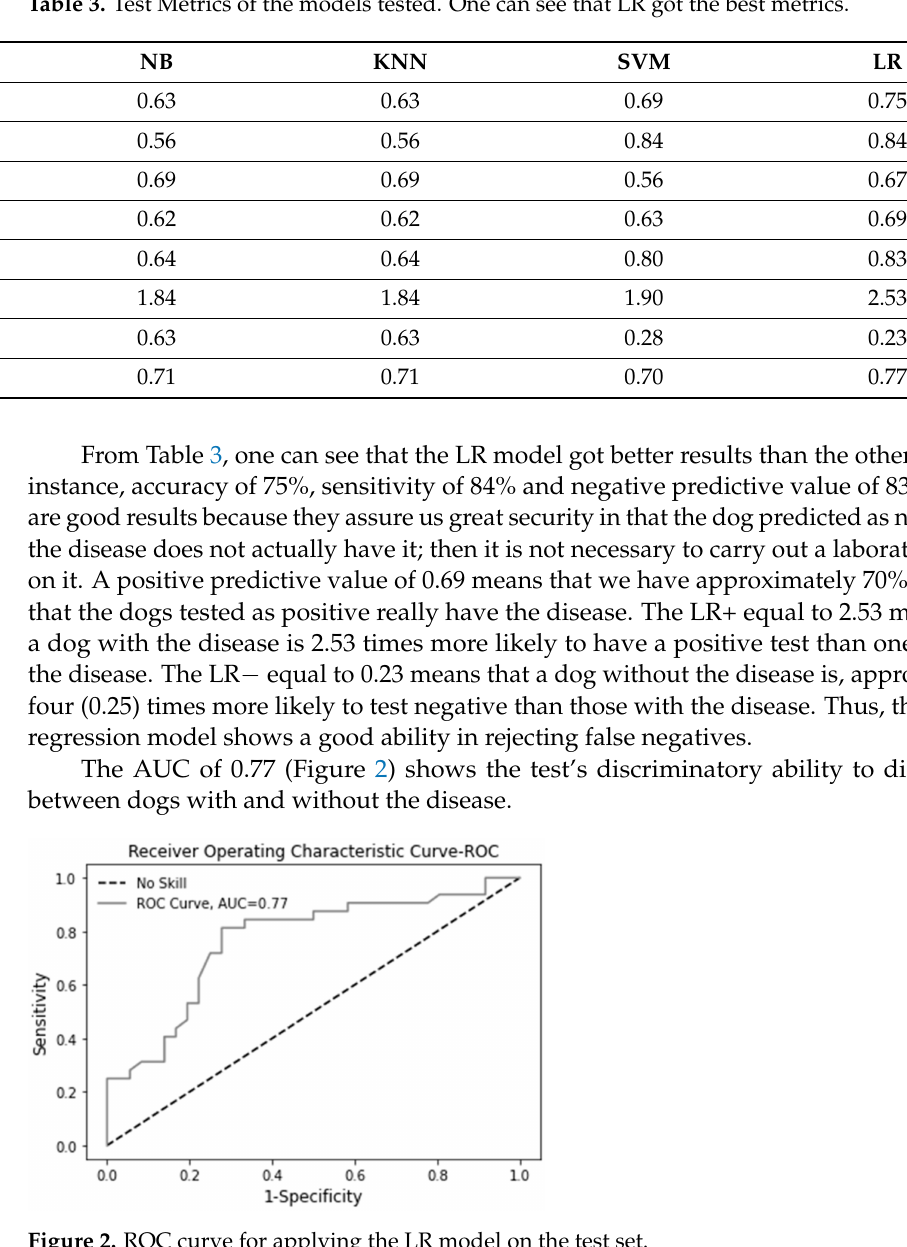
Figure 2. ROC curve for applying the LR model on the test